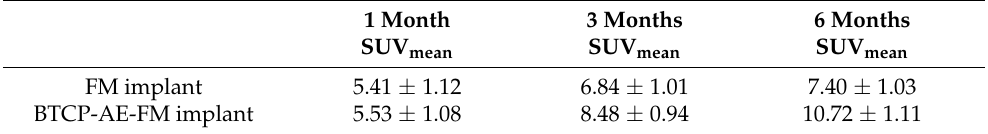
Table 2. Quantitative SUV analysis of the decay-corrected PET images obtained 1, 3, and 6 months after the surgery and 50 min after the intravenous injection of [ 18 F]fluoride. n = 6/time